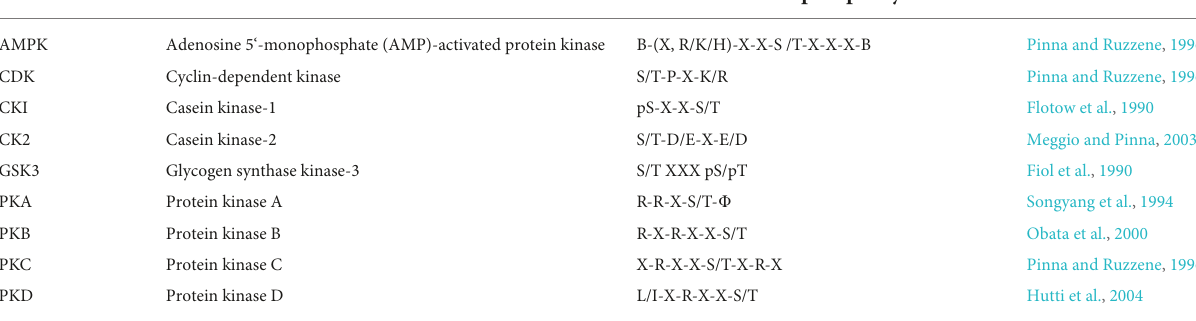
TABLE 1 Consensus phosphorylation sites catalyzed by common plant kinases. Protein